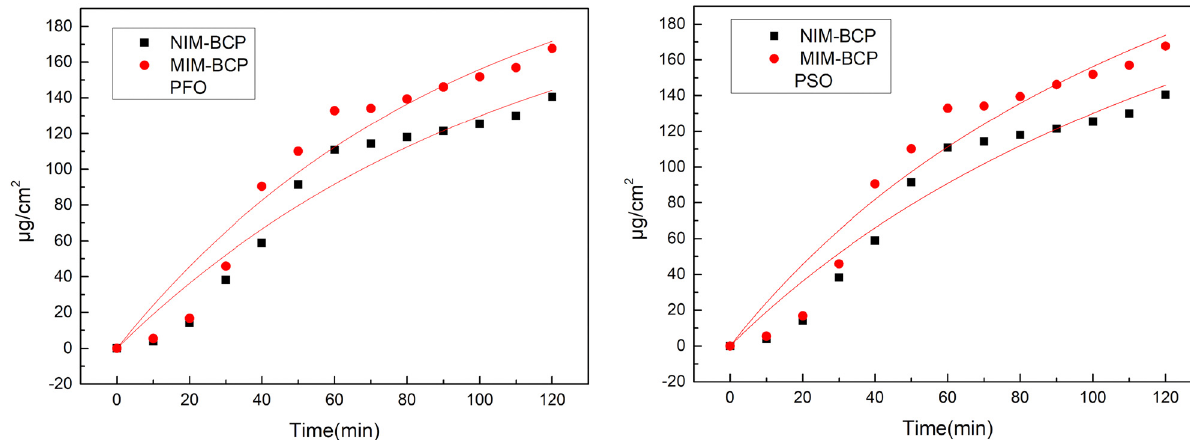
Figure A3: The Dynamic fi tting for PFO model and PSO